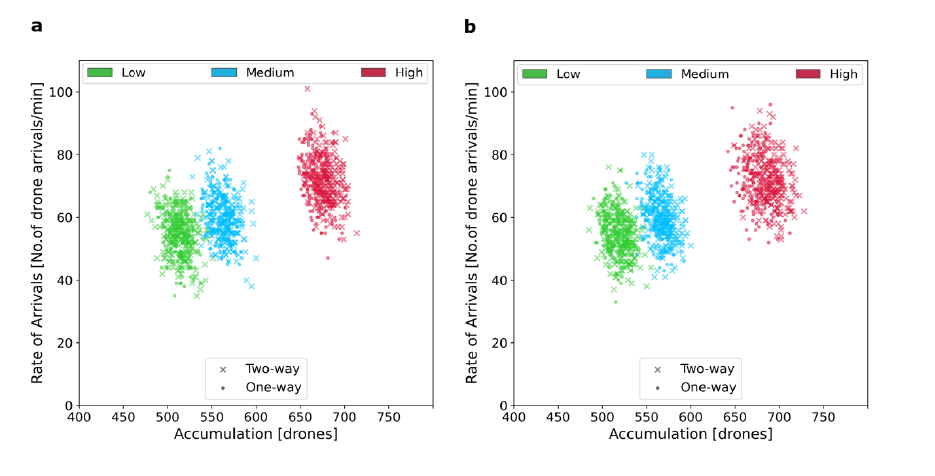
Figure 10. Rate of arrival for the two-way and one-way urban airspace concept for low, medium and high traffic demands. Each point represents the number of drone arrivals per minute. ( a ) Without conflict resolution. ( b ) With conflict resolution.